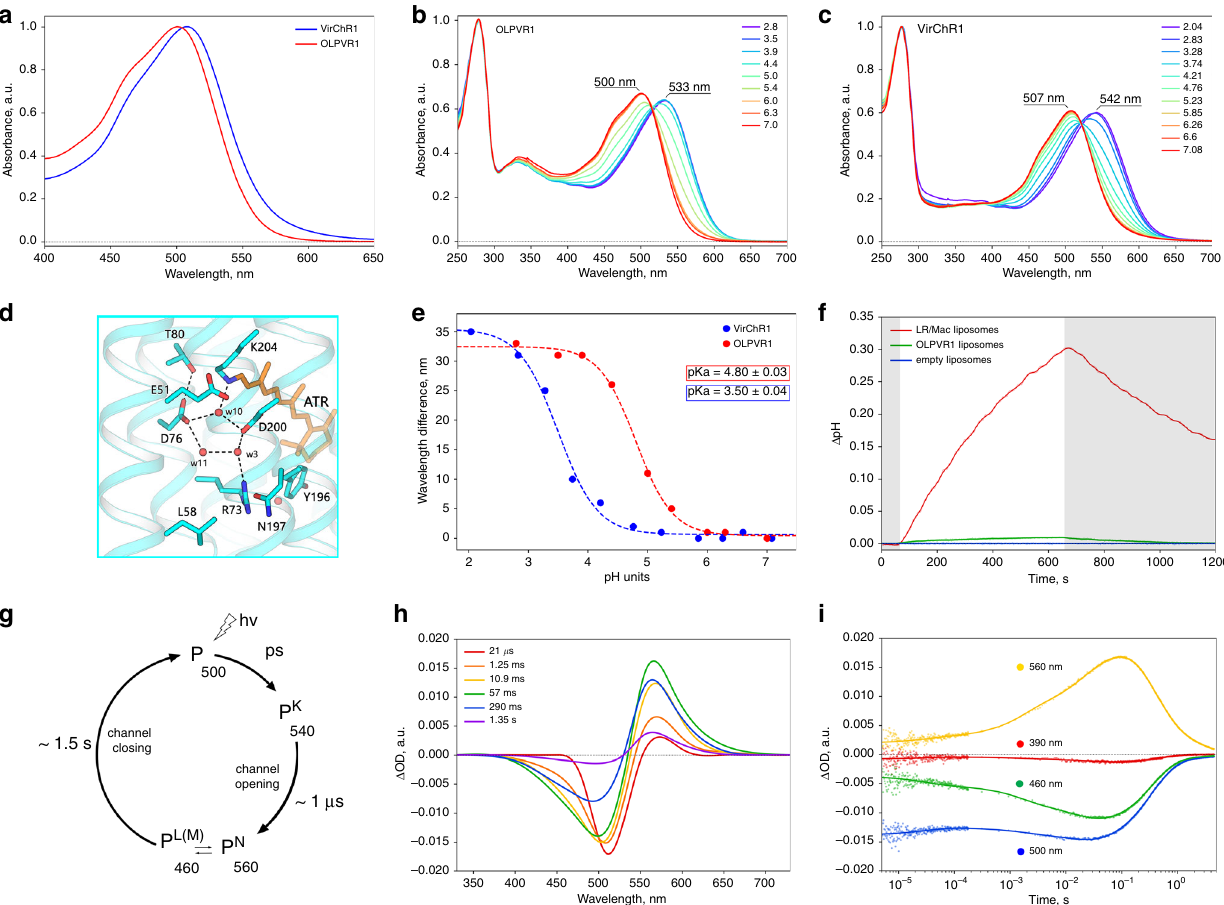
Fig. 2 Spectroscopic characterization of viral channelrhodopsins. a Normalized absorption spectra of OLPVR1 and VirChR1 proteins at neutral pH (pH 7.5). b , c Absorption spectra of OLPVR1 and VirChR1 at acidic (pH 2.1 – 7.1) pH range, normalized for absorption at 280 nm. d Schiff base region of OLPVR1 protein, key residues and water molecules are shown as sticks and spheres; hydrogen bonds are shown as dashed lines. e Absorption spectra of OLPVR1 at acidic (pH 2.8 – 7.0) pH range, normalized for absorption at 280 nm. e Red shift of UV-visible absorption spectrum and protonation of counterion of OLPVR1 and VirChR1. Wavelength maximum values are shown as circles. Sigmoidal curve fi ts are presented as dashed lines. The pK a values were calculated using a sigmoidal fi t. f Ion-transport activity assay of OLPVR1-containing proteoliposomes in 100 mM NaCl salt. The onset of illumination is indicated with white (light on) and gray (light off) background color, pH was adjusted to pH 6.0 prior to measurements. LR/Mac-containing liposomes and empty liposomes were used as positive and negative controls, respectively. g Schematic model of viral rhodopsins photocycle. h Transient absorption spectra and i time traces at speci fi c wavelengths of wild type OLPVR1 protein at pH